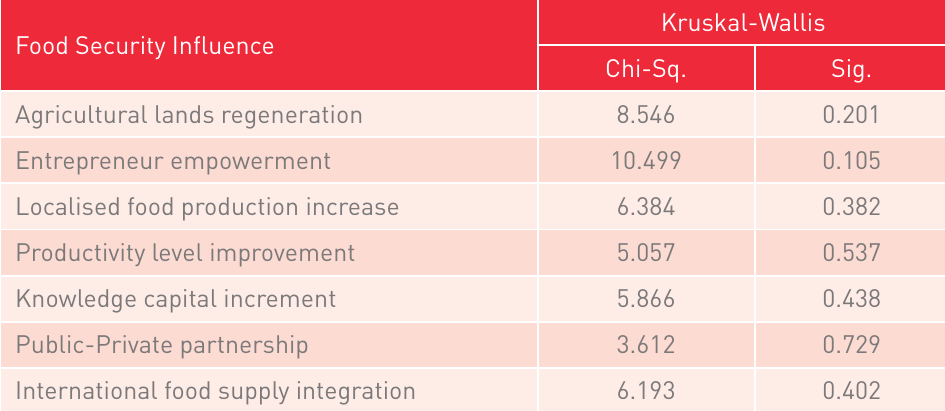
Table 2 Kruskal-Wallis H-Test for Influence of Food Security on Resilience Food Security